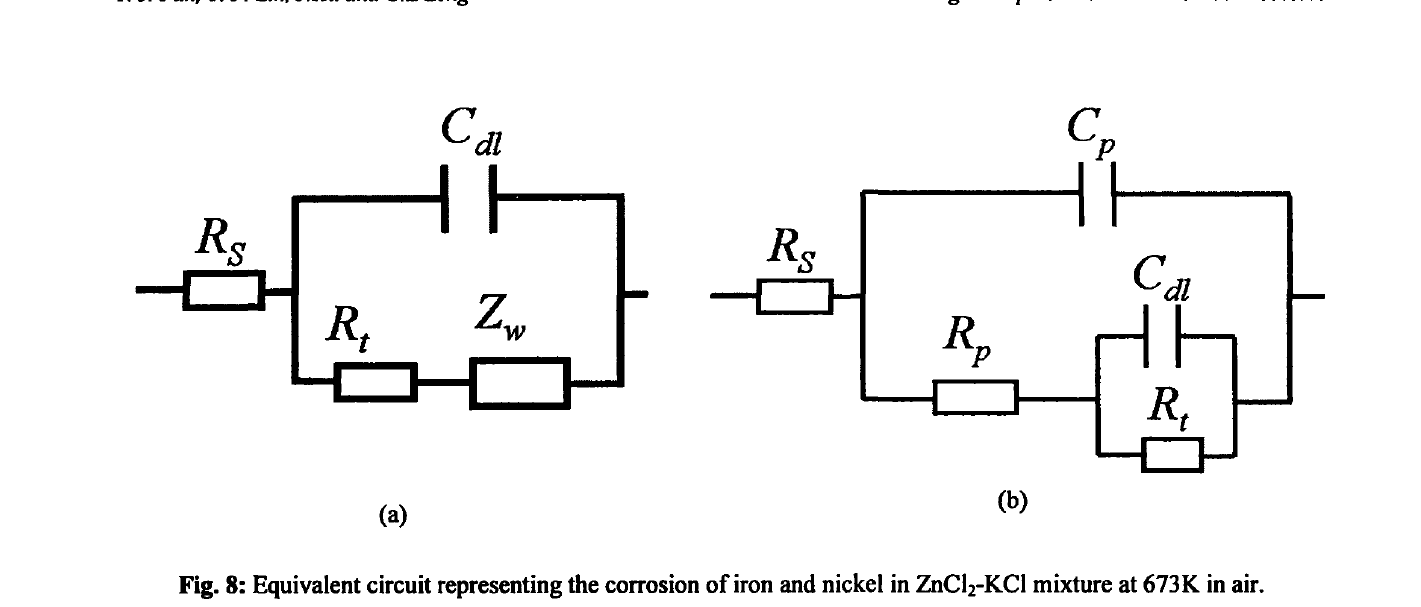
Fig. 8: Equivalent circuit representing the corrosion of iron and nickel in ZnCl